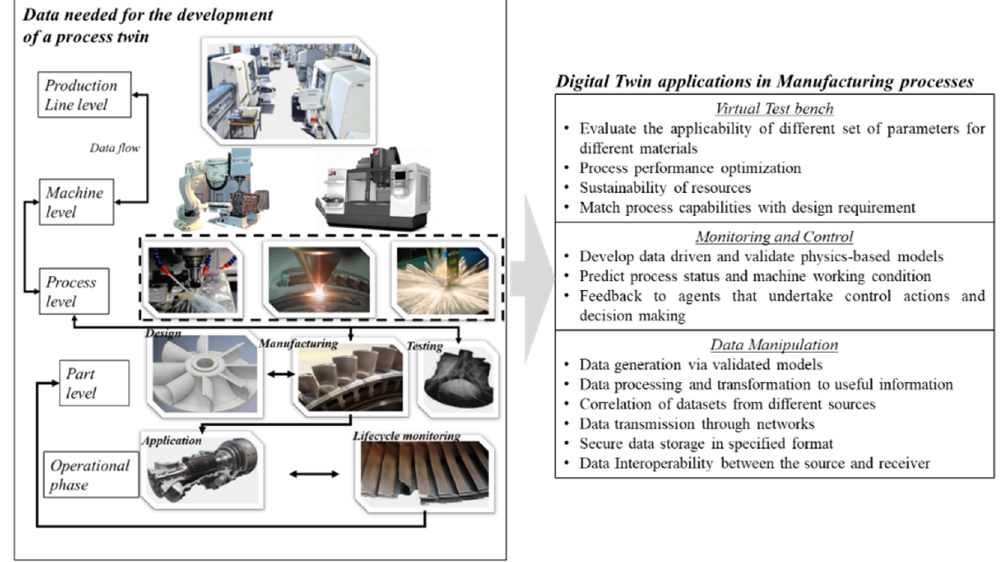
Figure 3. Digital Twin functionalities in manufacturing processes [34–38].